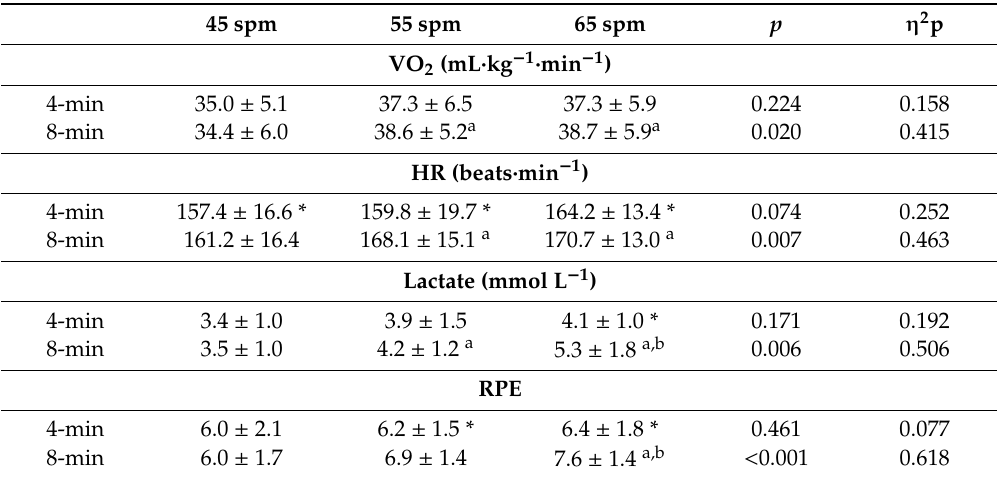
Table 3. VO 2 , HR, Lactate, and RPE variables of SUP Paddlers at 4-min and